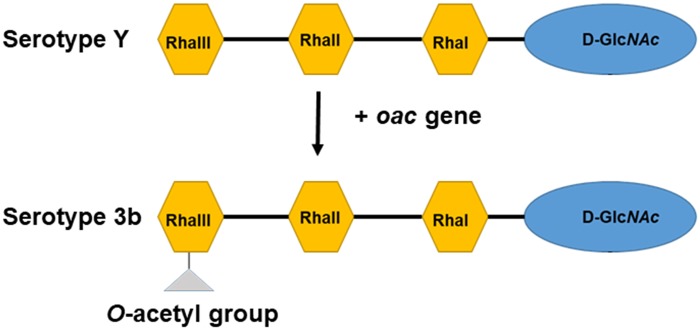
—Schematic representation of S. flexneri serotype Y and S. flexneri serotype 3b O-antigen. Each tetrasaccharide unit has one N-acetyl glucosamine (D-GlcNAc) and three rhamnose sugars (Rha).